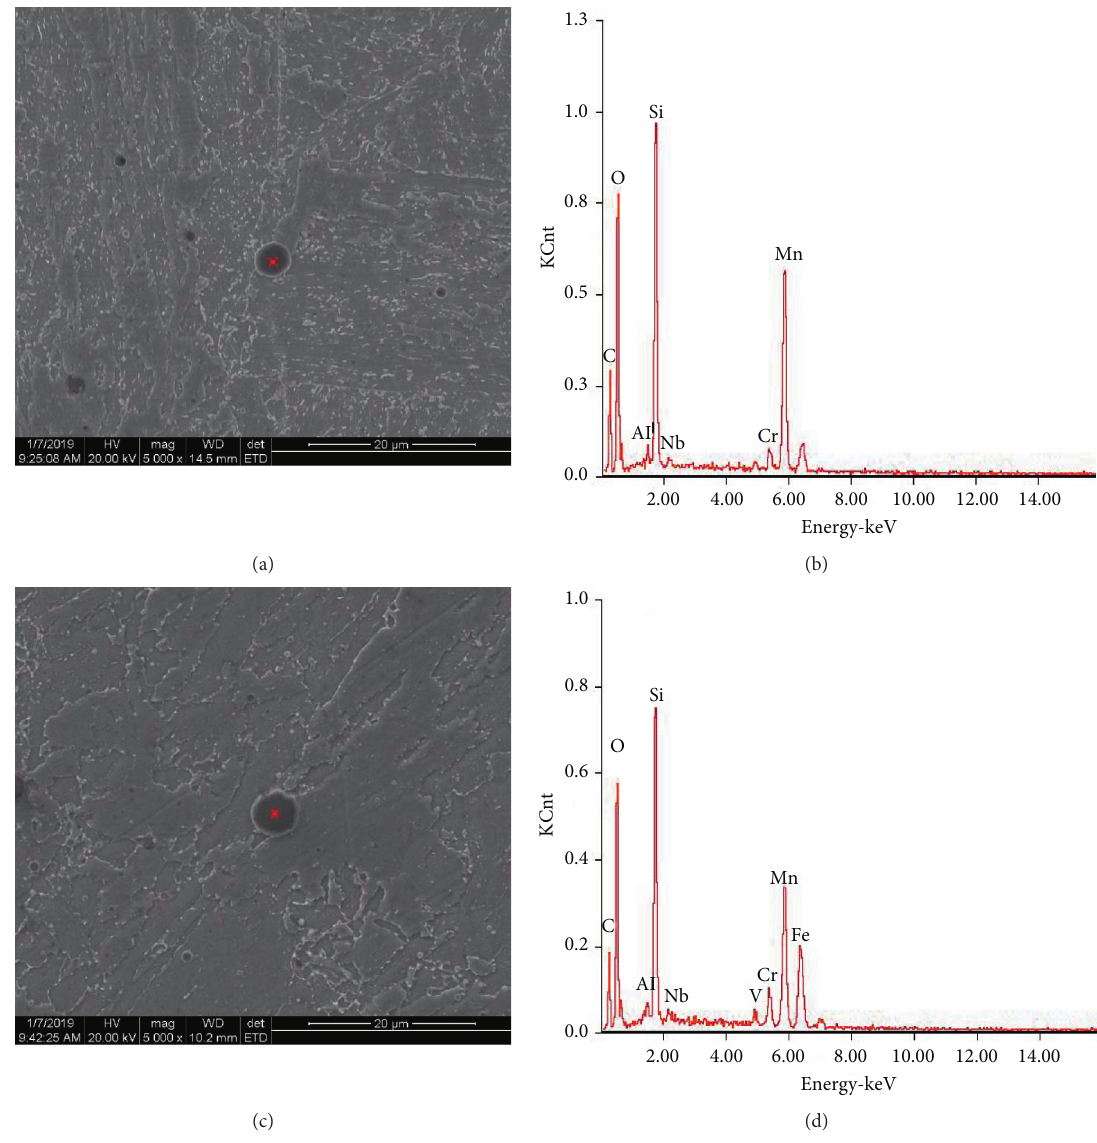
Figure 4: SEM image and EDS of the 2.25Cr1Mo0.25V sample made by WAAM, where sample #1 is in the as-cladded state.